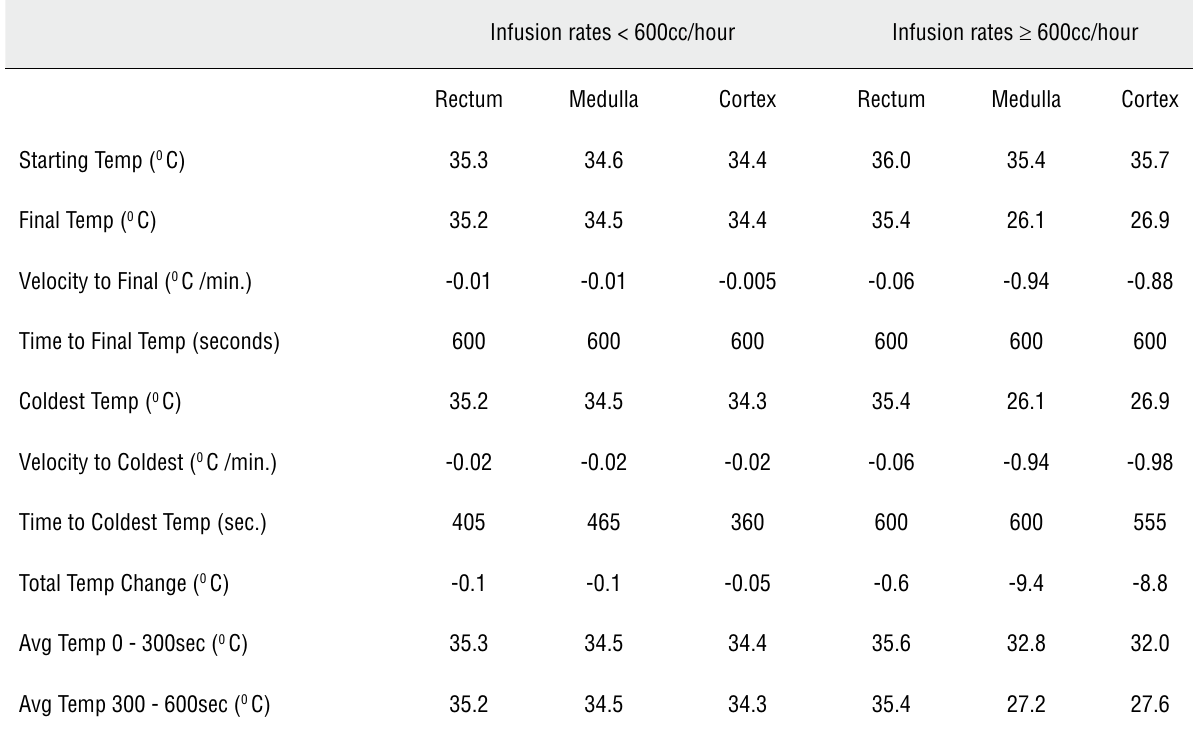
Table 1 - Retrograde cooling for low and high infusion rates with hilar